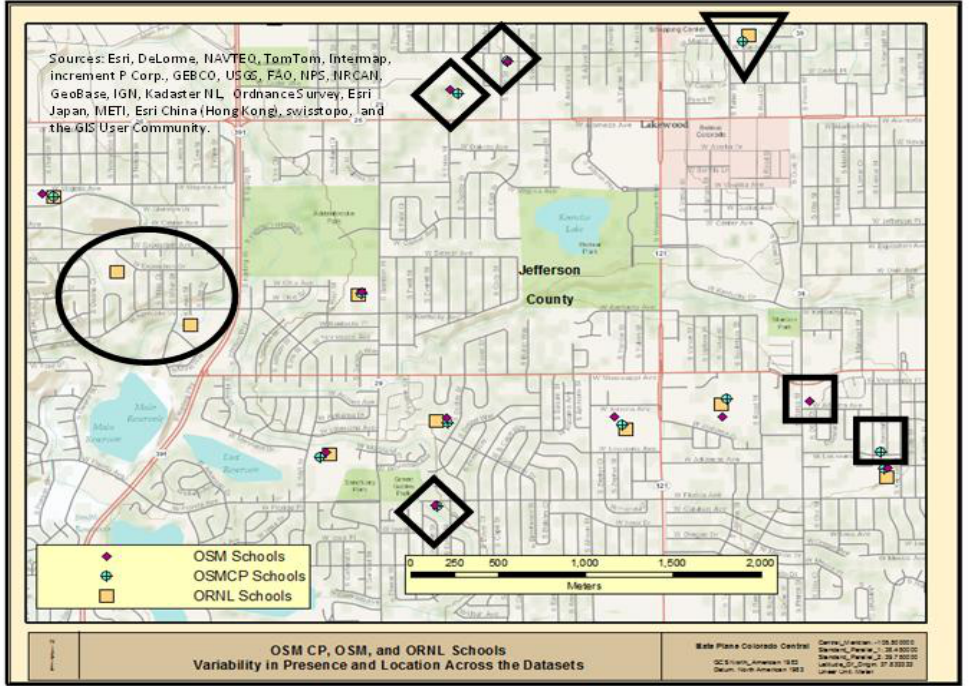
Figure 2. Comparison of OSM, OSMCP, and ORNL